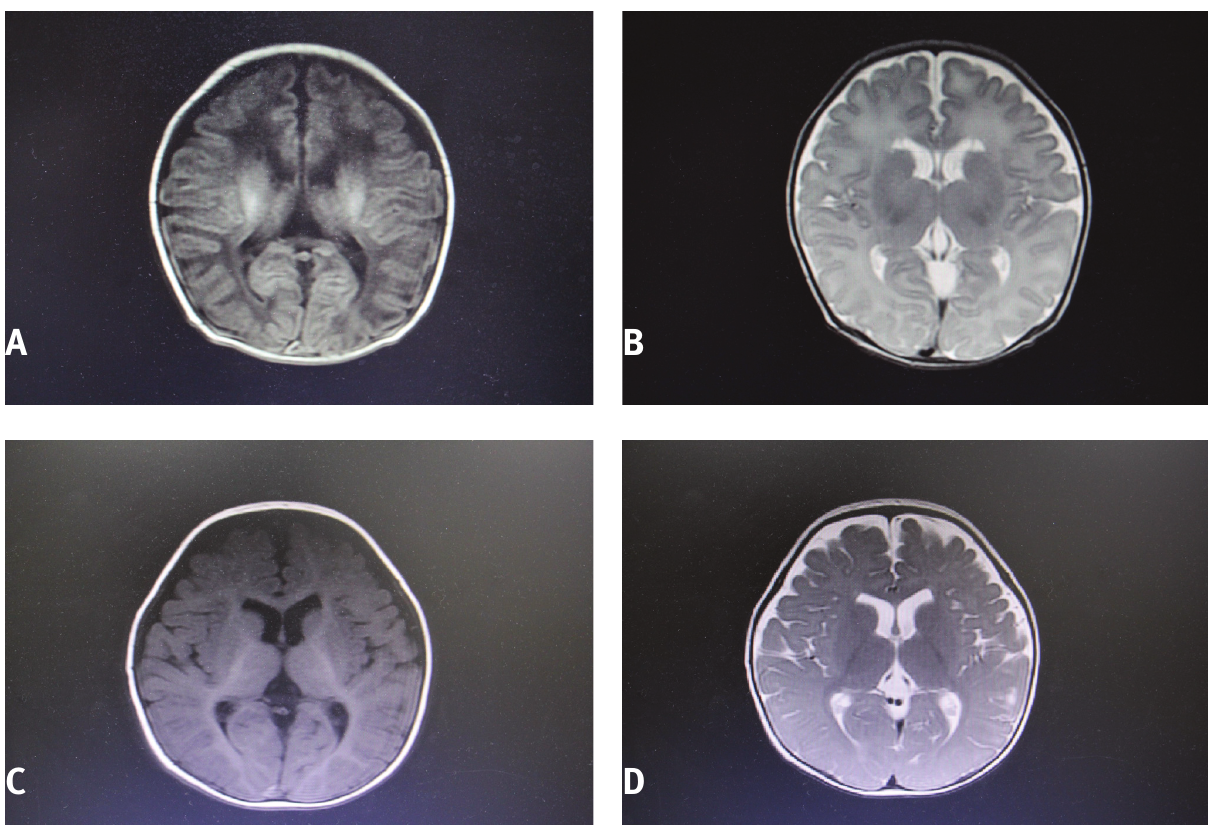
Figure 1: A case in the hydrogen water treatment group before and after treatment. The male patient weighed 3.1 kg and had a history of choking. A and B: At 12 h after birth, MRI scanning showed symmetrical long T1 and long T2 signals in the white matter near the anterior horns of both lateral ventricles. FLAIR and DWI showed a low signal, and DTI indicated an FA value of 0.316. C and D: After the hydrogen water treatment, the abnormal signal disappeared and DTI indicated an FA value of